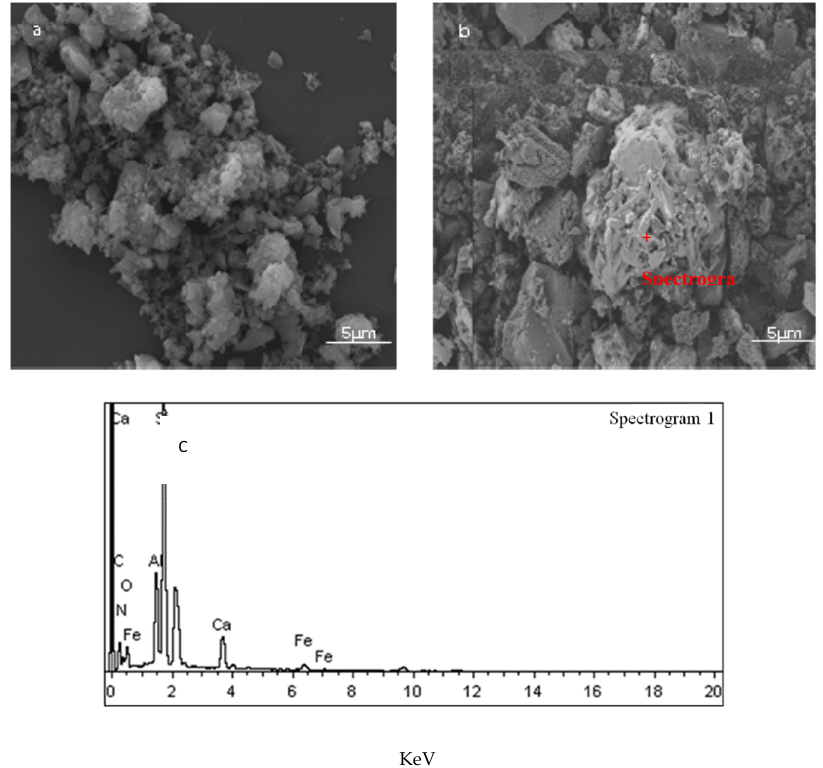
Figure 1. XRD images of the samples prepared from PRL( a ) and TE ( b ) at 1450 °C for 2 h.